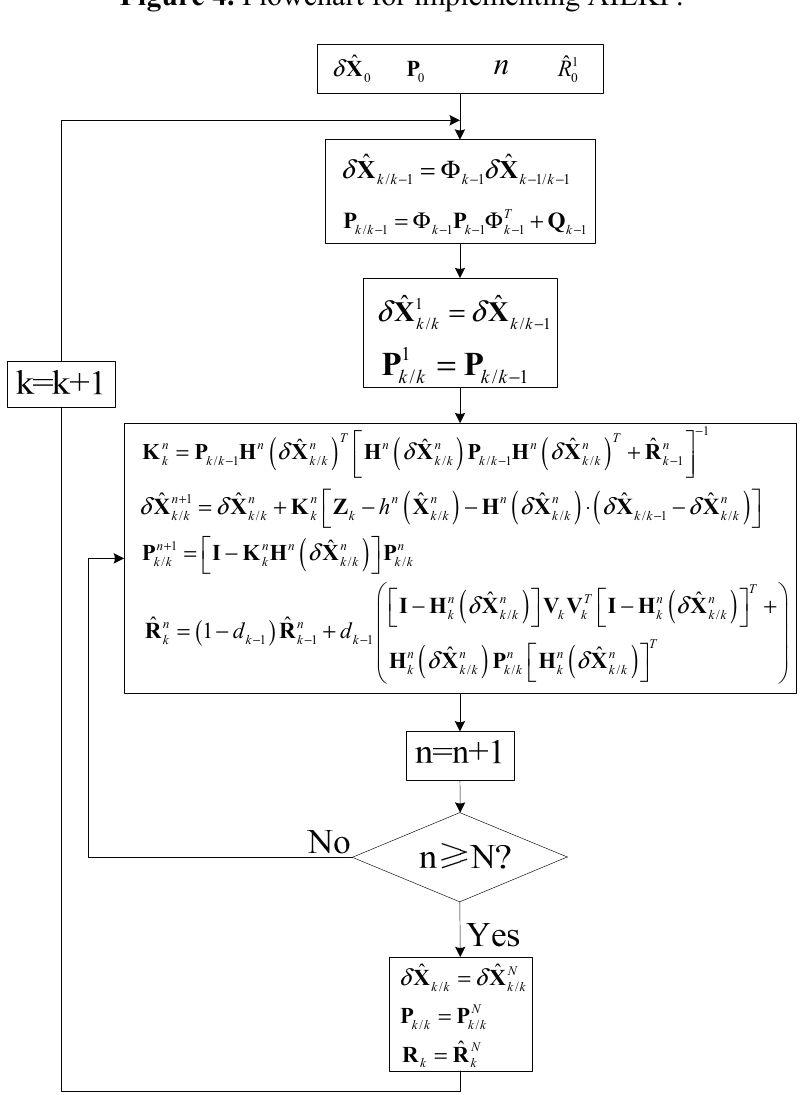
Figure 4. Flowchart for implementing